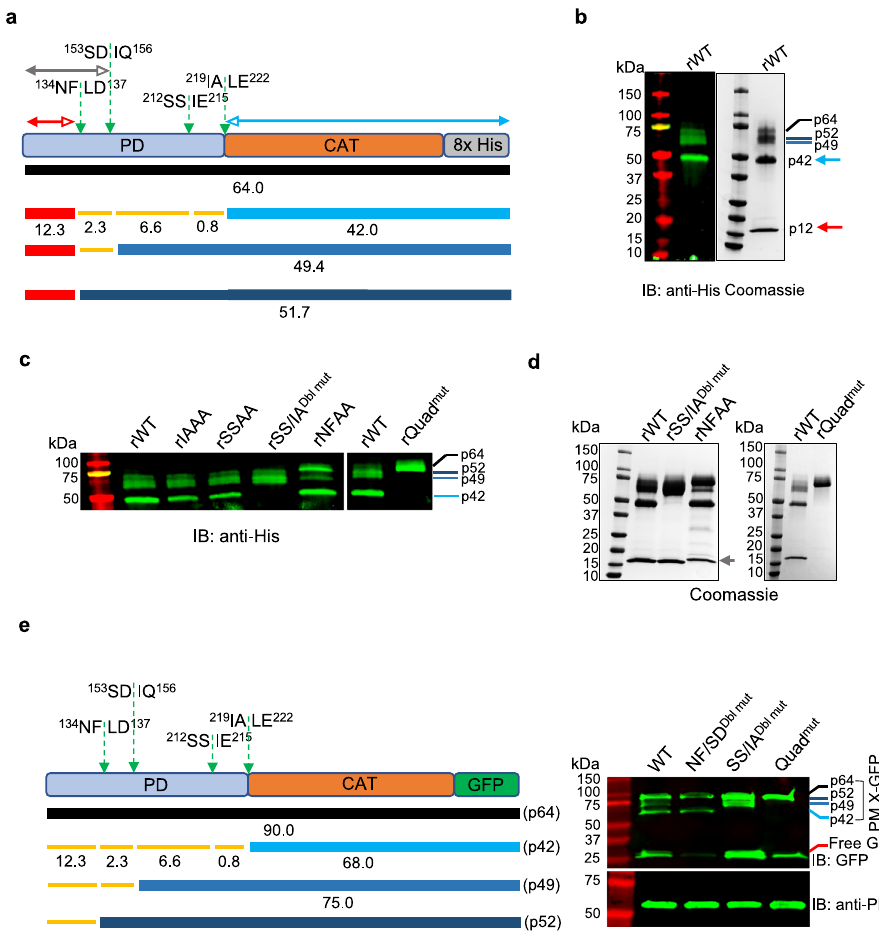
Fig. 1 | Autoprocessing sites are conserved between the heterologously expressed and parasite PM X. a Schematic of the likely identities of the different processed forms of C-terminally 8x His tagged PM X (rPM X) expressed from the HEK293 cells. Predicted mass of the polypeptides based on their amino acid compositionsareindicated.Thicklinesindicatetheprocessedfragmentsthatwere detected either by western blot or by Coomassie blot. Orange thin lines represent processed bands not detected. Amino acid sequence fl anking the PM X auto- cleavage sites are indicated with positional information. Green dotted arrows represent the scissile bonds. PD prodomain, CAT catalytic domain. The red, blue and gray arrows represent the peptide coverage regions obtained from LC/MS. Filled arrow heads: tryptic ends, empty arrow heads: nontryptic ends. Colors cor- respond to the bands highlighted by same color arrows in b and d . Additional mutatedconstructs used in this study are depictedin Supplementary Fig. 1. b Left,